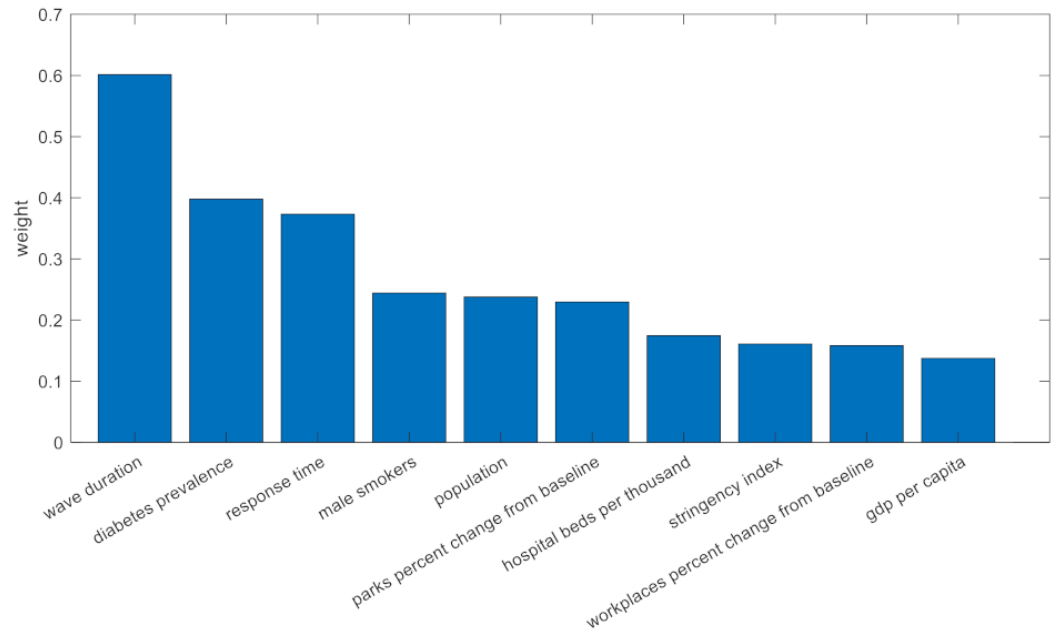
Figure 3. Impact of the selected risk factors for wave 1.